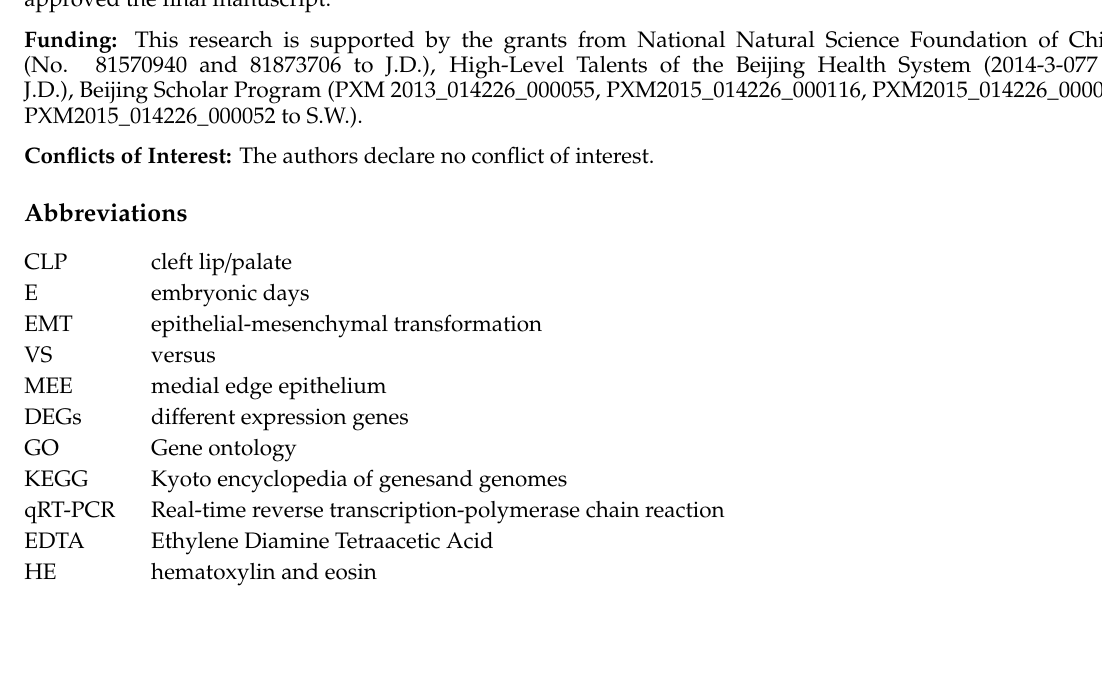
s1. Table S1. Summary of sequence data generated for miniature pig secondary palate development transcriptome, and quality filtering. Table S2. Alignment results of 15 libraries mapping to the reference transcriptome. Table S3. All di ff erentially expressed genes with p ≤ 0.05 compared with the other palate development stages. Table S4. The genes involving significant GO groups ( p ≤ 0.05) in E30–50. Table S5. The genes involving significant pathways ( p ≤ 0.05) in E30–50. Table S6. The genes and pathways identified by signal-gene analysis. Table